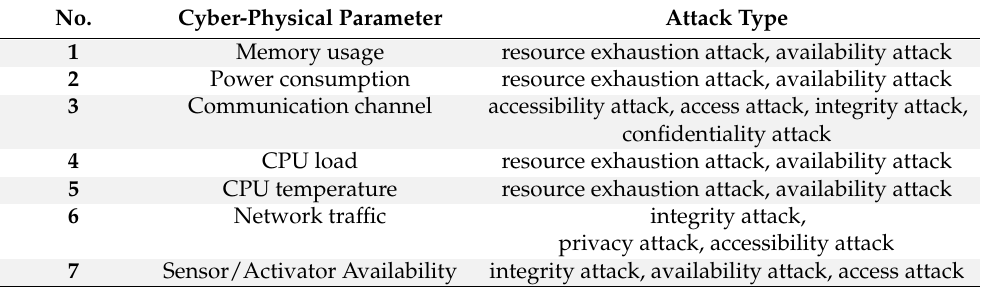
Table 1. Influence of various types of attacks on the cyber-physical parameters of the sensor system.